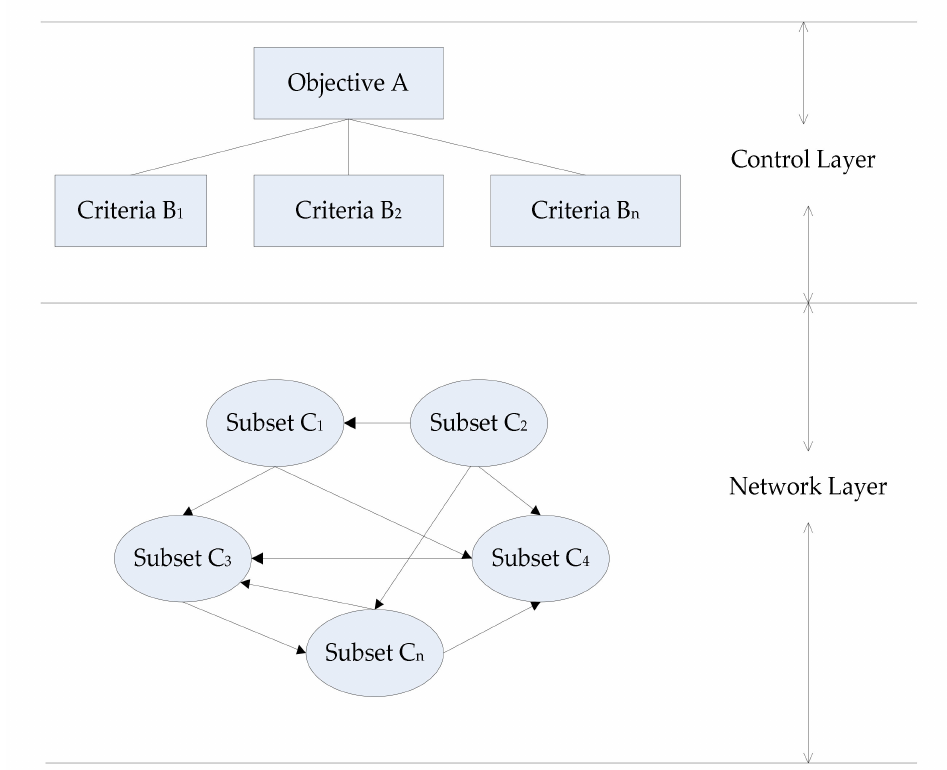
Figure 7. Typical ANP